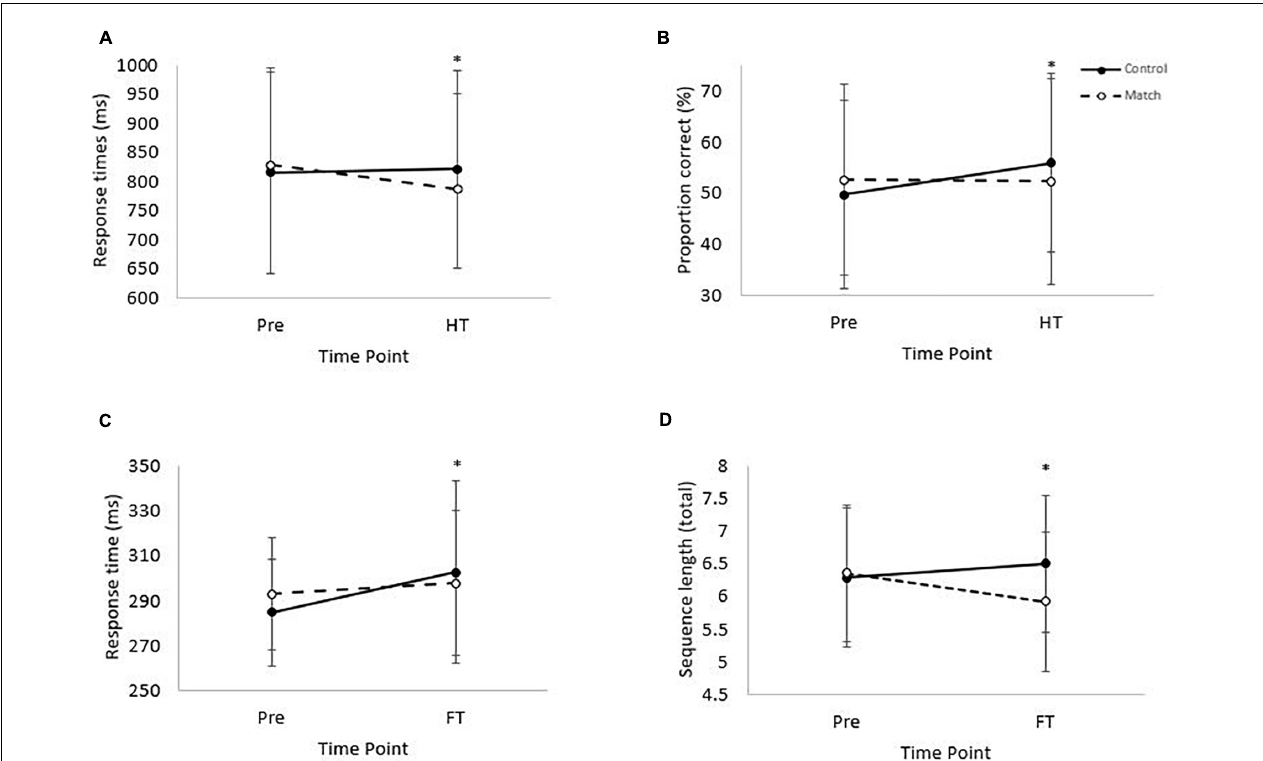
FIGURE 2 | (A) Response times on the complex level of the Stroop test. Pre, prior to the match; HT, half-time. (Trial ∗ time interaction, ∗ P < 0.01). Data is mean ± SD. (B) Proportion correct on the RVIP test. Trial ∗ time interaction, P = 0.04. Pre = baseline and HT = half-time. (Trial ∗ time interaction, P = 0.04). Data is mean ± SD. (C) Response time on the simple level of the Visual Search test. (Main effect of time, P < 0.01; trial ∗ time interaction, P < 0.01). Pre, baseline; FT, full-time. Data is mean ± SD. (D) Mean sequence length from pre-match to full-time for the Corsi Blocks test. Main effect of trial ( P = 0.03), and trial ∗ time interaction ( P < 0.01). Data is mean ±